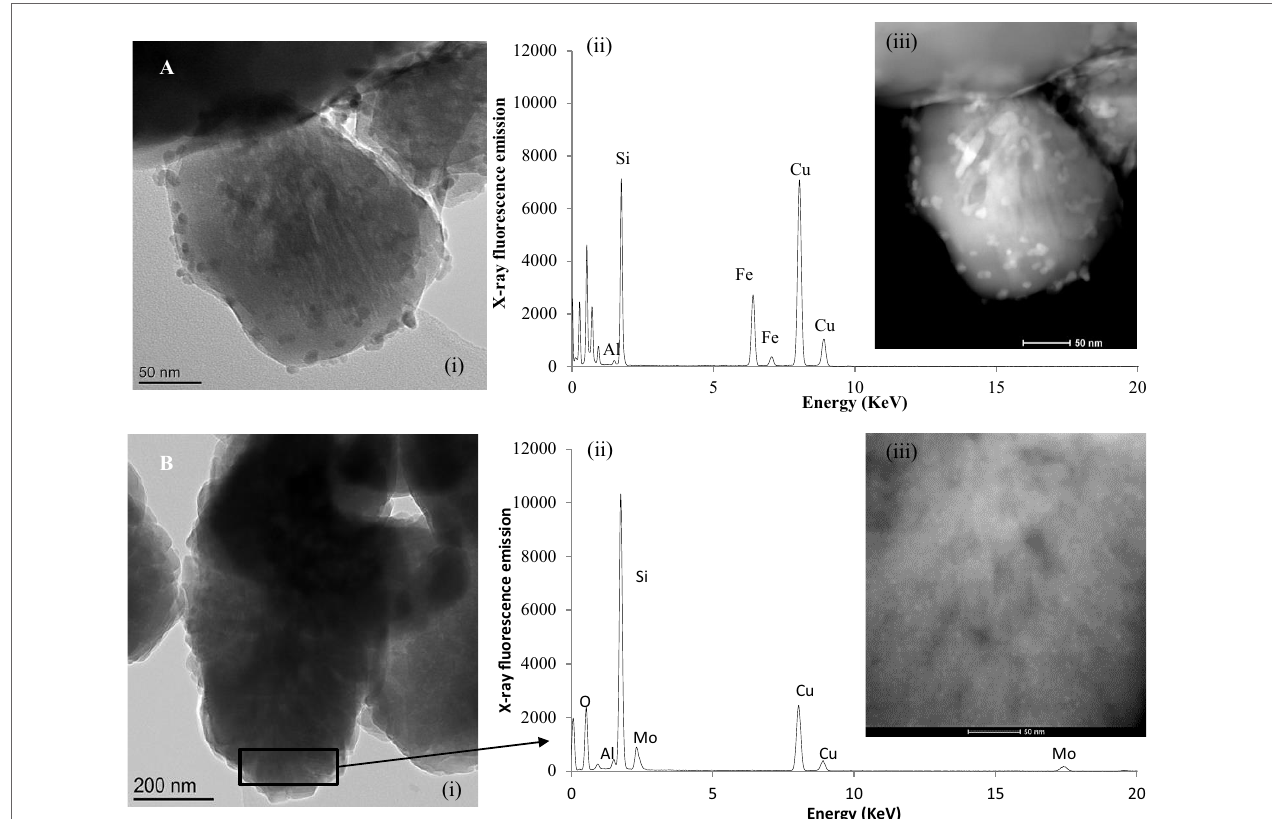
FigUre 2 | sTeM of different metal-doped hZsM-5, where (a) is FeZsM-5 and (B) is MoZsM-5; (i) sTeM analysis; (ii) eDX (iii) analysis of the haaDF (high-angle annular dark field)